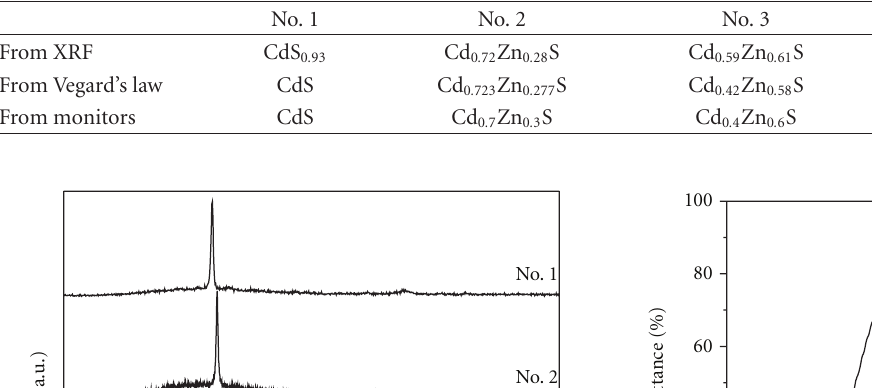
Table 1: Composition of Cd 1 − x Zn x S thin films.